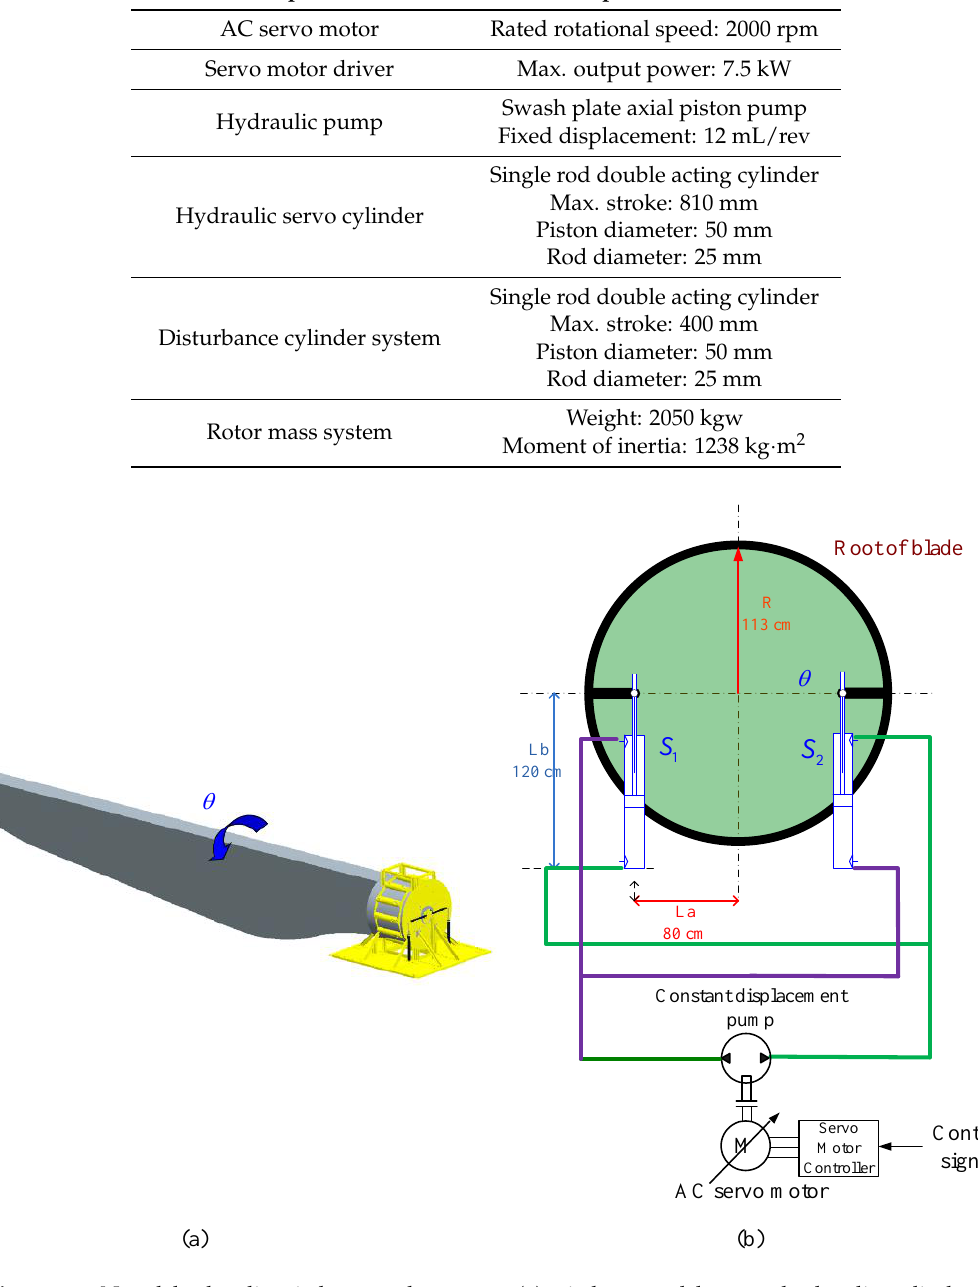
Figure 2. Test rig of novel variable pitch control system of wind turbine driven by hydraulic pump- controlled dual-cylinder system. Figure 2 is the test rig of hydraulic pump-controlled pitch system. The rotor mass system, which is designed in accordance with the blade of the 2 MW wind turbine serves to simulate its dynamic characteristics so that the rotor mass denotes 2050 kgw and its moment of inertia indicates 1238 kg m 2 The disturbance system consists of two hydraulic cylinders and two proportional pressure control valves for adjusting the loading torque that is calculated in the simulation software FAST according to the wind speed. The PC-based control system performs the control strategy and the data acquisition. Therefore, the experimental system of pitch control can be implemented for analyzing